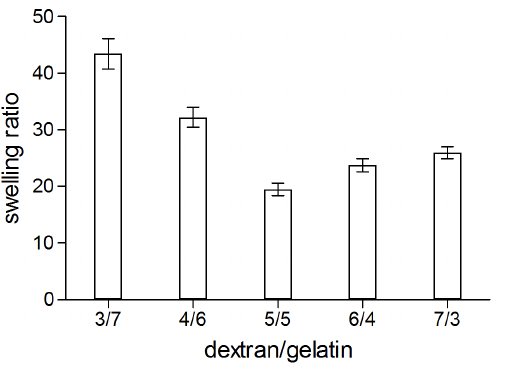
Figure 6. The degradation of dextran/gelatin hydrogels with different volume